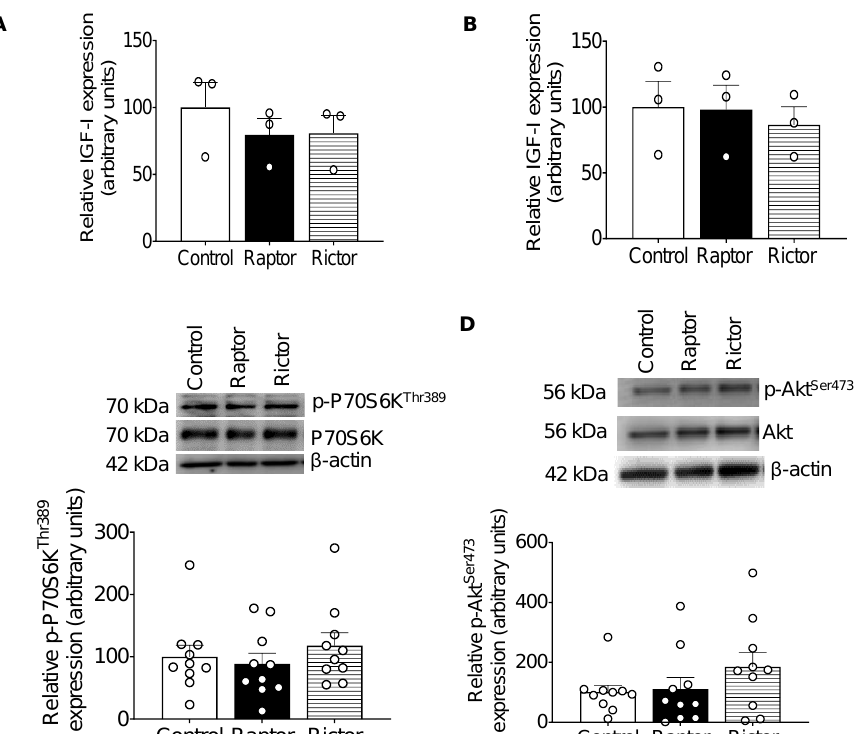
Figure 8. ELISA analysis of IGF-1 secretion before and after treatment of HepG2 cells with CM from PHT cells with the control, RAPTOR , and RICTOR siRNA and densitometric analysis of mTORC1 and mTORC2 functional readouts from cell lysates of HepG2 treated with CM from PHT cells with the control, RAPTOR , and RICTOR siRNA. IGF-1 secretion was determined in CM from PHT cells with the control, RAPTOR , and RICTOR siRNA before treatment of HepG2 cells ( A ) and CM from HepG2 cells after treatment with CM from PHT cells with the control, RAPTOR, and RICTOR ( B ). Equal aliquots (50 µ L) of CM were analyzed with an IGF-1 ELISA kit. A representative Western blot of HepG2 cell lysates (35 µ g protein) displaying p-P70S6K Thr389 ( C ) and p-Akt Ser473 ( D ) in HepG2 cells treated with CM from PHT cells with the control, RAPTOR, or RICTOR siRNA. Samples were normalized to the control. The data were represented as Mean + SEM in bar figures and analyzed with a one-way ANOVA and Bonferroni Multiple Comparison tests; p < 0.05 was considered